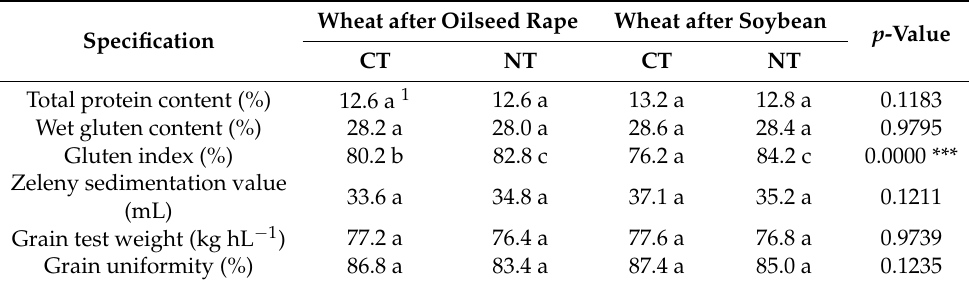
Table 6. Interactive dependencies of previous crop and tillage system in determining the quality parameters of winter wheat grain (mean for 2014–2017).